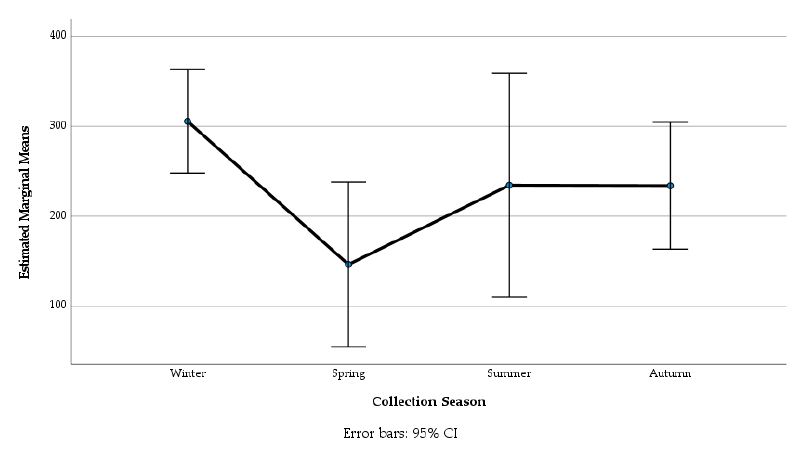
Figure 3. Estimated marginal mean strongyle egg counts during different seasons in horses in Ire- land.